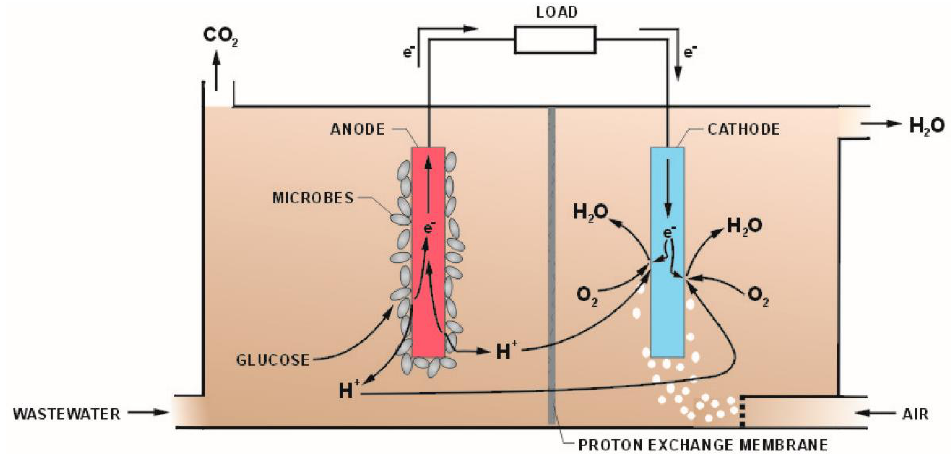
Figure 2. Operating principles of a microbial fuel cell (MFC) (Reprinted with permission from Ref. [32])